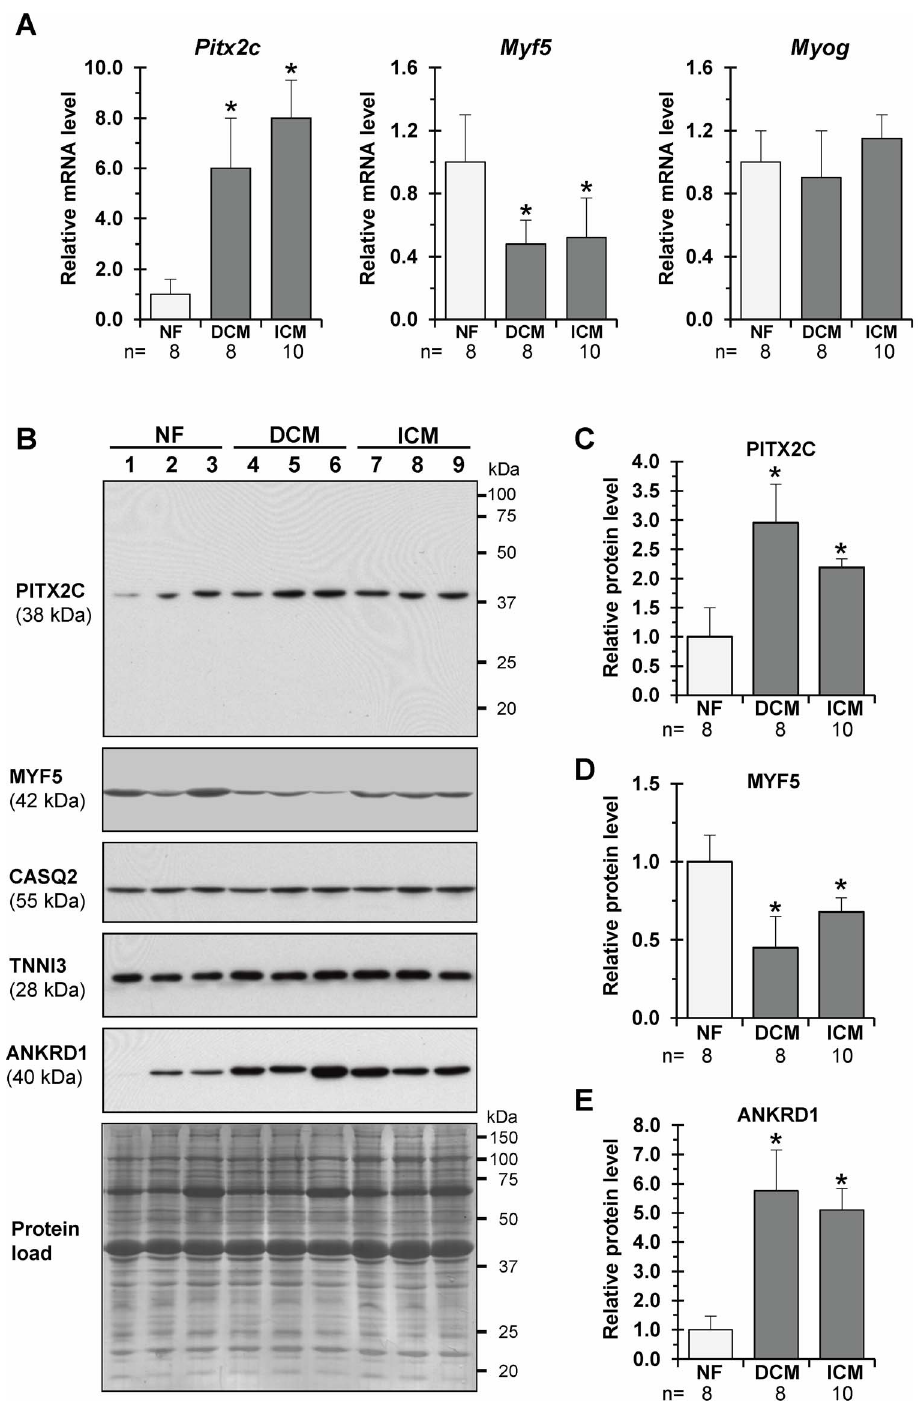
Figure 5. Pitx2c expression is reactivated, while expression of Myf5 is downregulated in human systolic heart failure as determined by qRT-PCR and Western blot analyses. A - Overall relative levels of Pitx2c , Myf5 , and Myog transcripts in the left ventricular (LV) samples from non-falling (NF) and failing human hearts due to idiopathic dilated (DCM) and ischemic (ICM) cardiomyopathy. *p # 0.05. B - Representative Western blots of PITX2C levels (top) in the LV samples from NF (Lane 1–3), DCM (lane 4–6) and ICM (lane 7–9) failing hearts. Western blot replicates were probed with antibodies against MYF5, cardiac calsequestrin 2 (CASQ2), cardiac troponin I (TNNI3) and ankyrin repeat domain 1 protein (ANKRD1). MW values (kDa) of the bands detected are shown. Protein load - Membrane stained with Amido Black 10B. Overall relative levels of PITX2C (C), MYF5 (D) and ANKRD1 (E) protein in LV-samples as based on average values from each group studied. *p # 0.05.